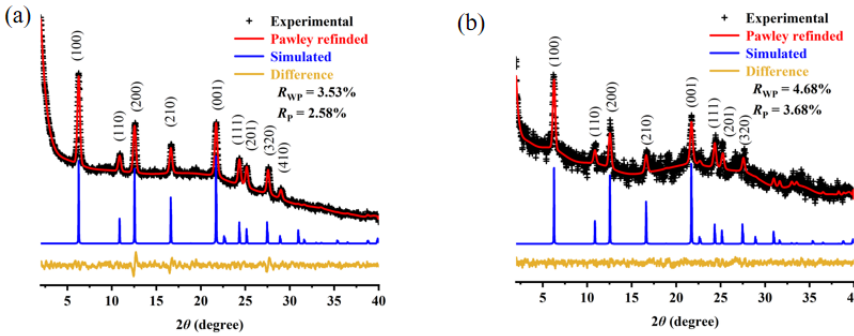
Crystals 2022 , 12 , x FOR PEER REVIEW Figure 1. PXRD patterns of JUC − 624 ( a ) and JUC − 625 ( b ). Figure 1. PXRD patterns of JUC − 624 ( a ) and JUC − 625 ( b ).